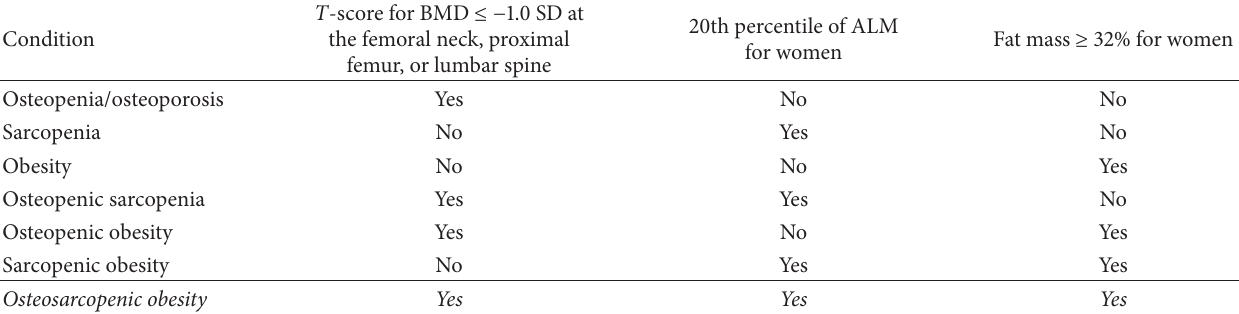
Table 1: Diagnostic criteria for osteosarcopenic obesity based on body composition (via dual energy X-ray absorptiometry, DXA).